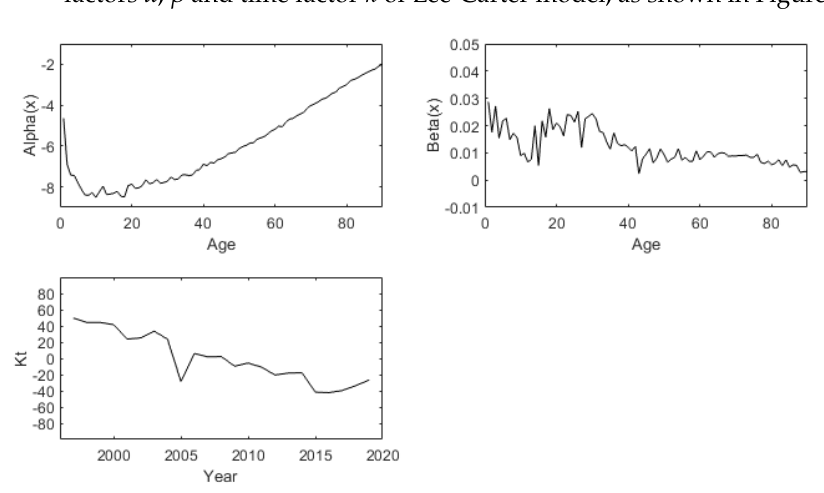
Figure 3. Fitted components of basic LC method for females of China (1996:2019).